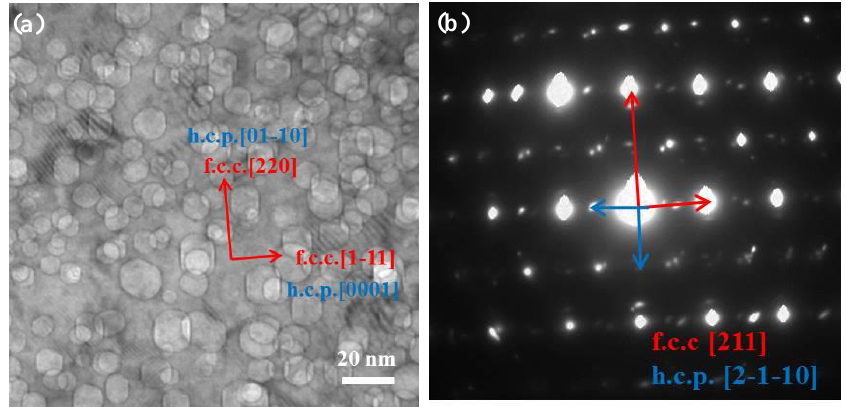
Figure 8. ( a ) TEM micrograph and ( b ) SAED pattern show the evidence of the co-existence of fcc and hcp phases along with helium bubbles in the irradiated area.